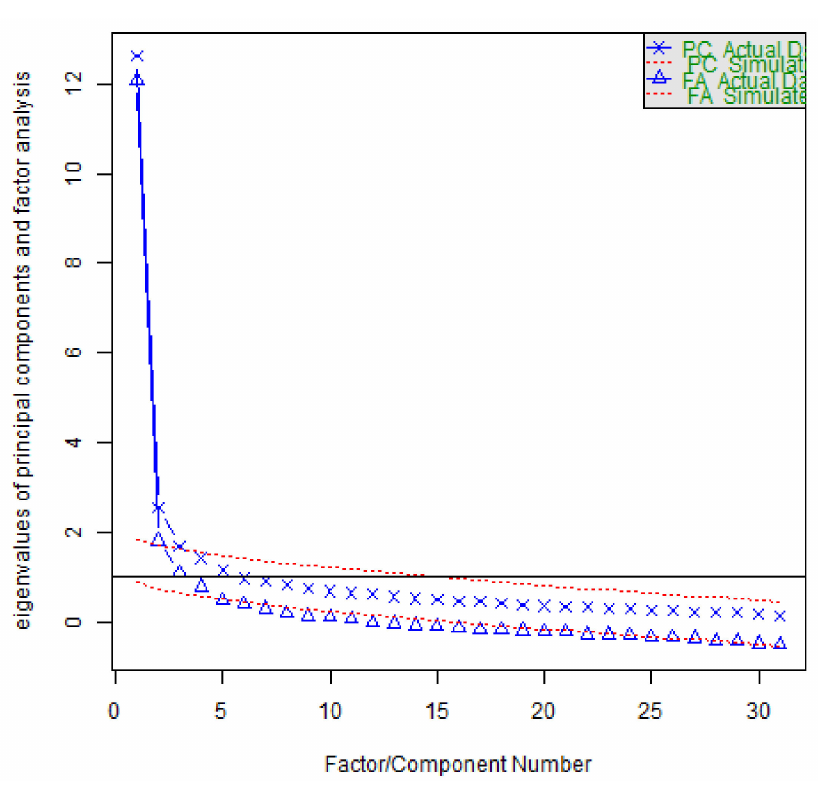
Figure 1. Parallel analysis of the questionnaire gravel